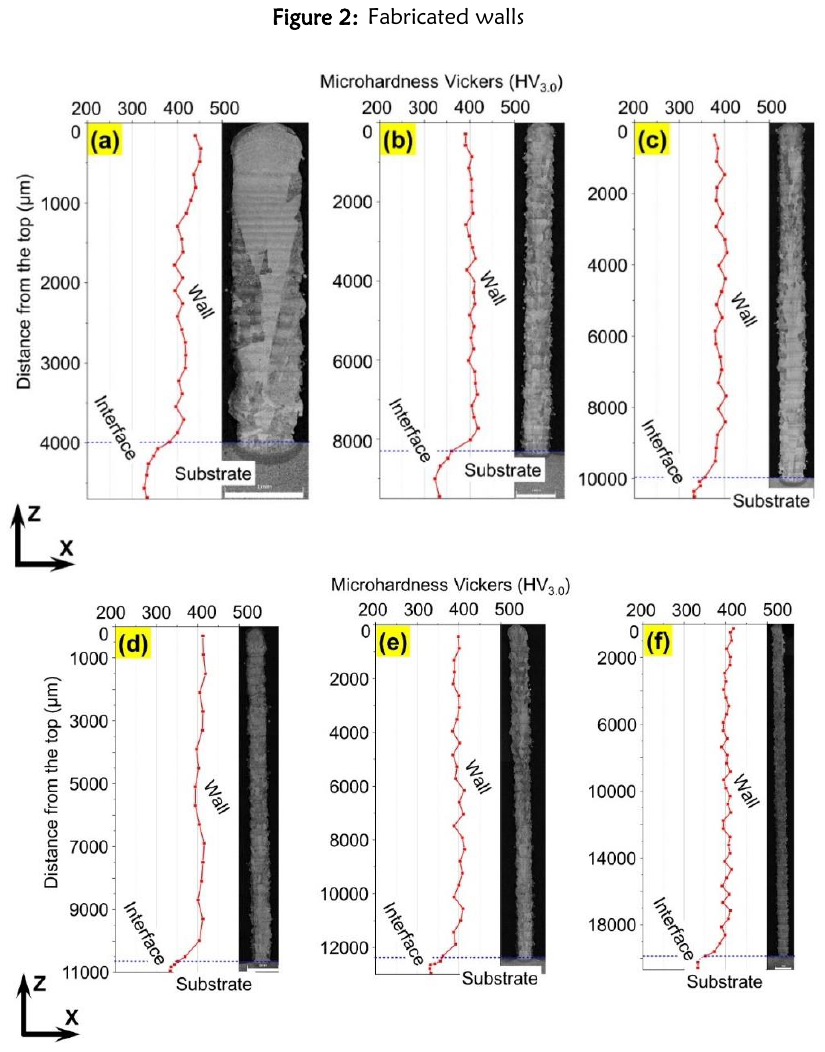
Figure 3: Vickers microhardness profiles. Conditions according to Table 3. Etching: Kroll’s